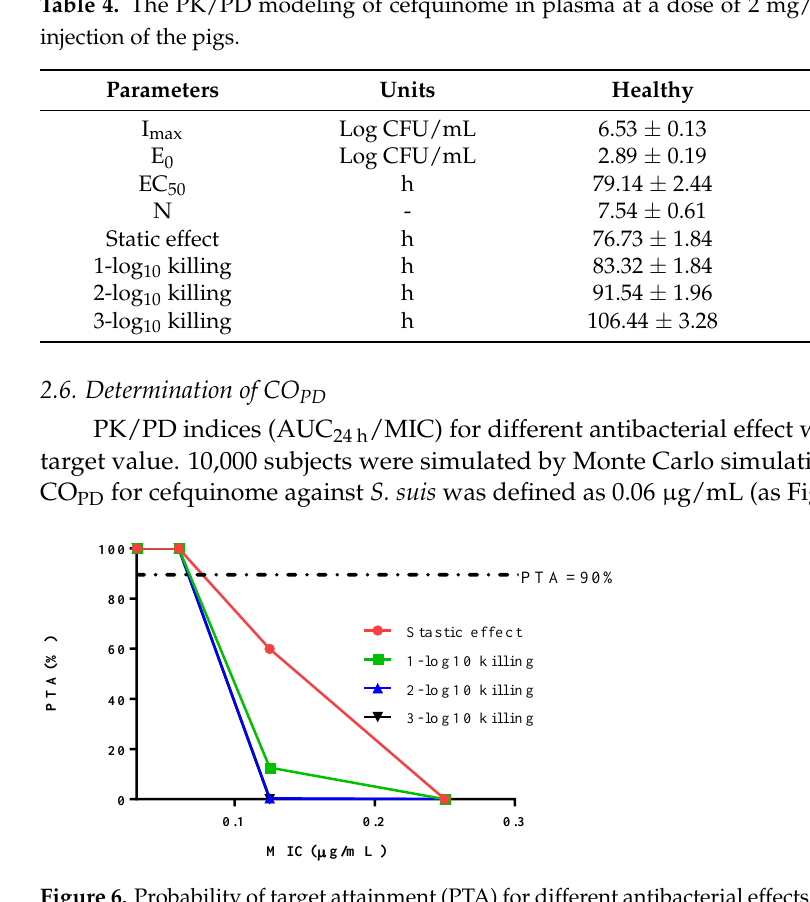
Figure 6. Probability of target attainment (PTA) for different antibacterial effects on the healthy